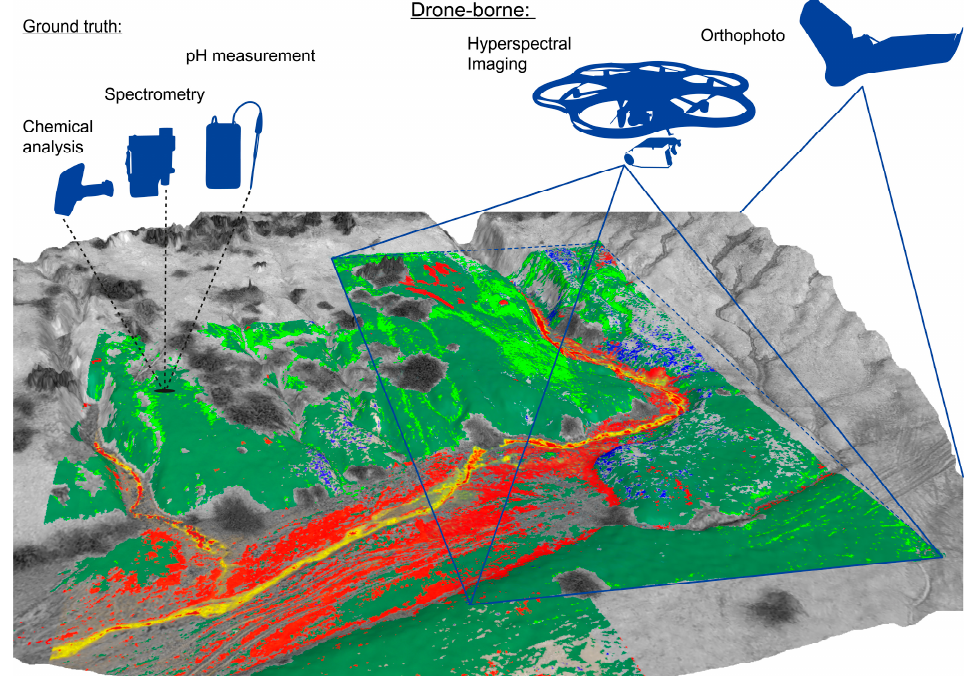
Figure 1. Workflow during the field work for the Litov campaigns. The two main working procedures, the UAS-based data acquisition (right corner) and the ground validation (left corner), are shown. Superimposed on a 3D model of the landscape are two classified HSI scenes.